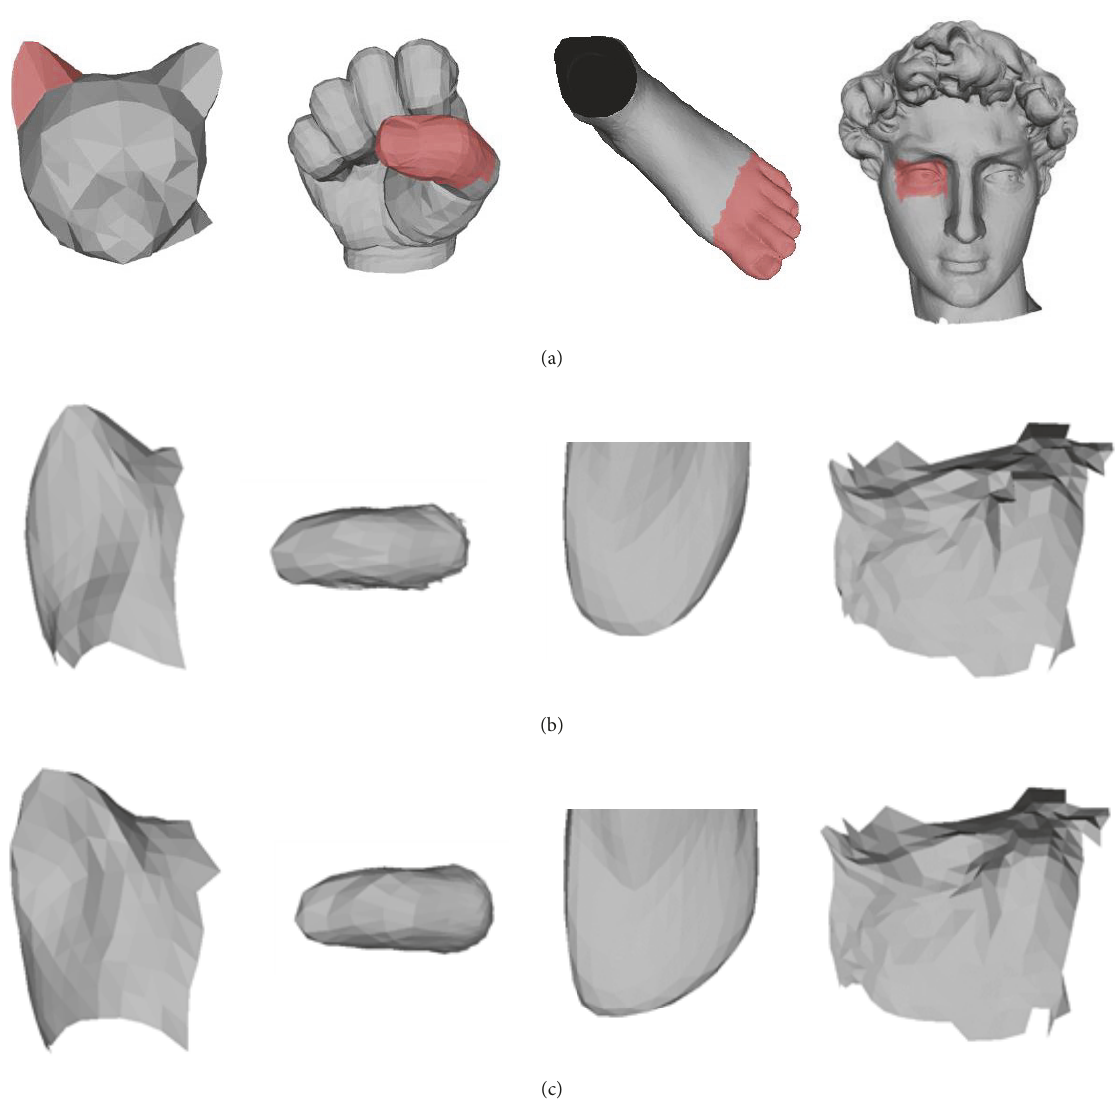
Figure 11: Qualitative results of ROI compression with JPEG2000 codec. (a) to (c): original meshes, reconstructions using non-ROI compression, and reconstructions using ROI compression.